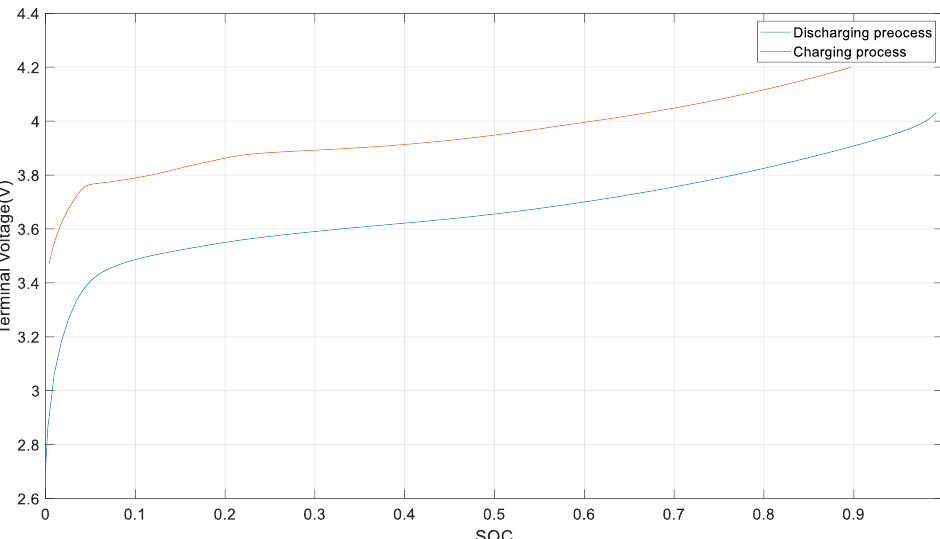
Figure 5. Internal equivalent circuit model of lithium-ion battery.